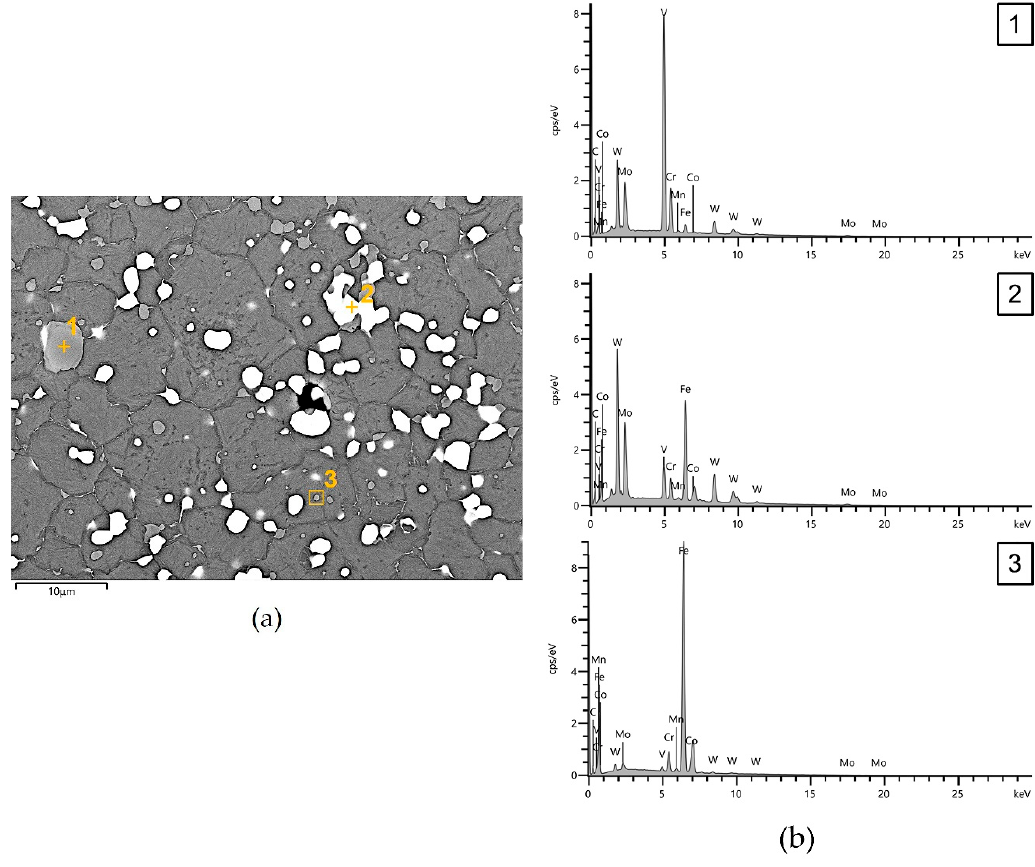
Figure 4. ( a ) BSE-SEM micrograph of the microstructure observed on the cross-section of taps after quenching and ( b ) semi-quantitative EDS analyses (wt.%) of different carbide particles in the same microstructure.